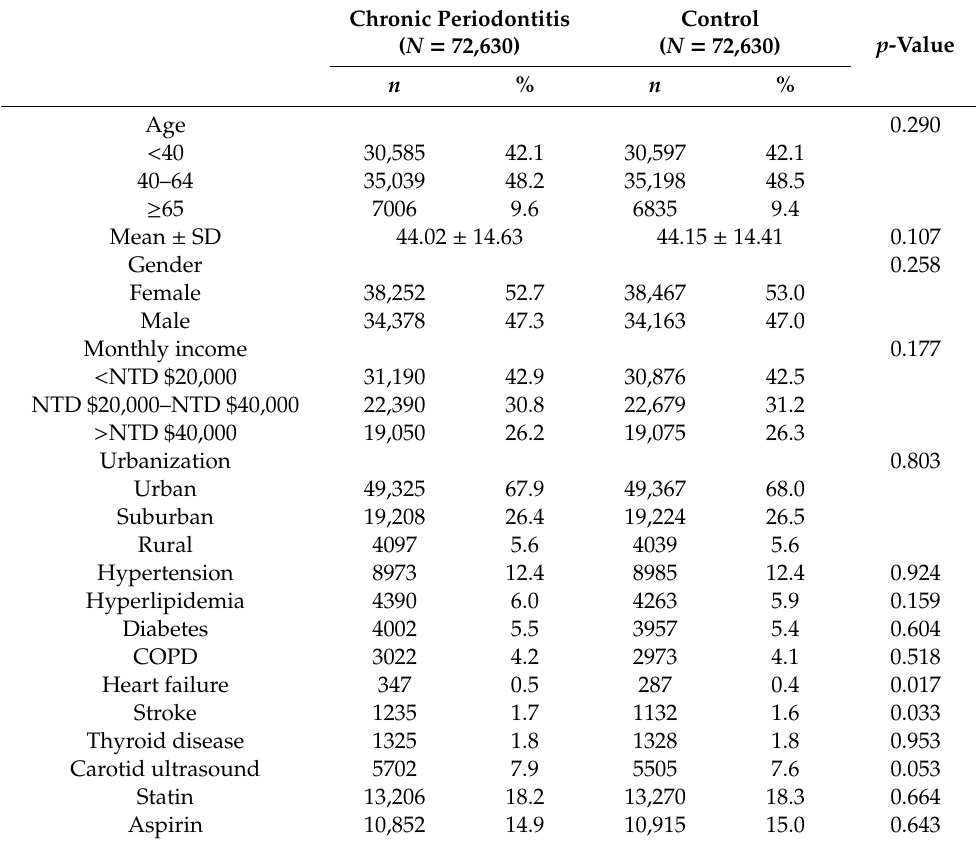
Table 1. Demographic data of matched study